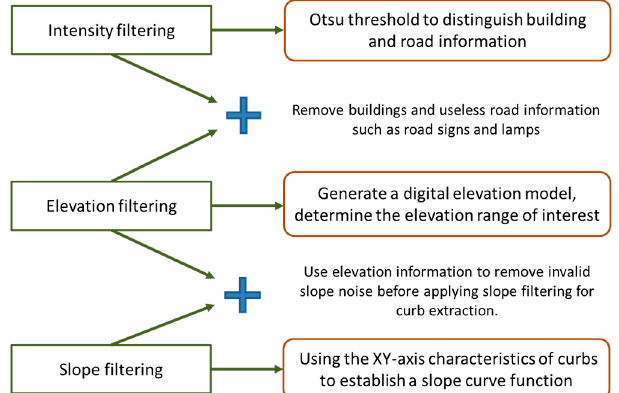
Figure 4. The workflow of the extraction algorithm.